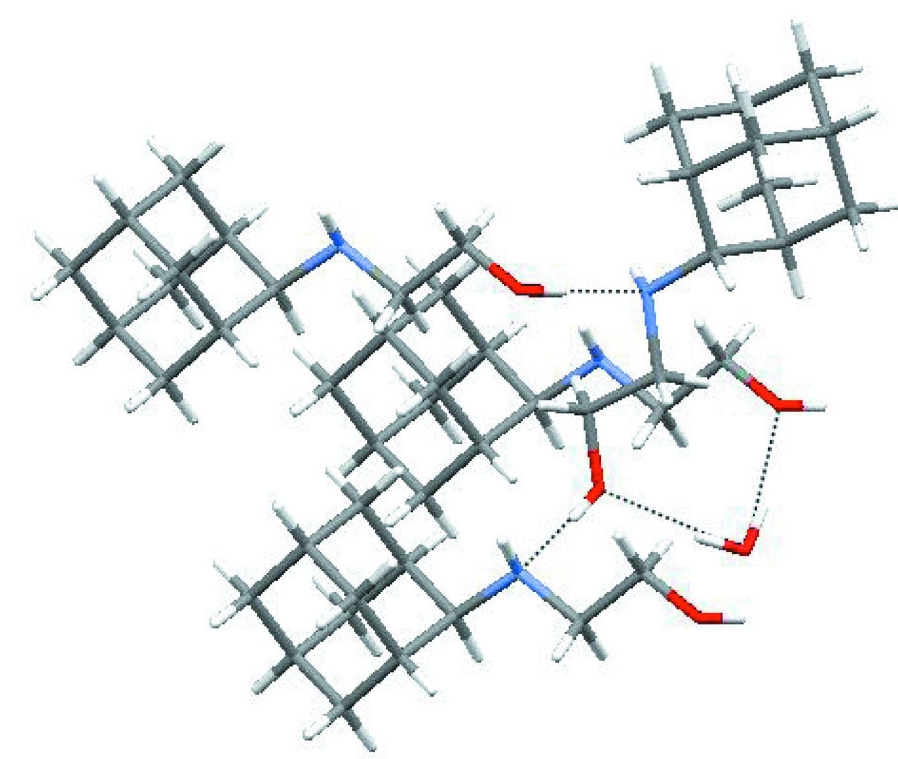
Figure depicting the intermolecular hydrogen